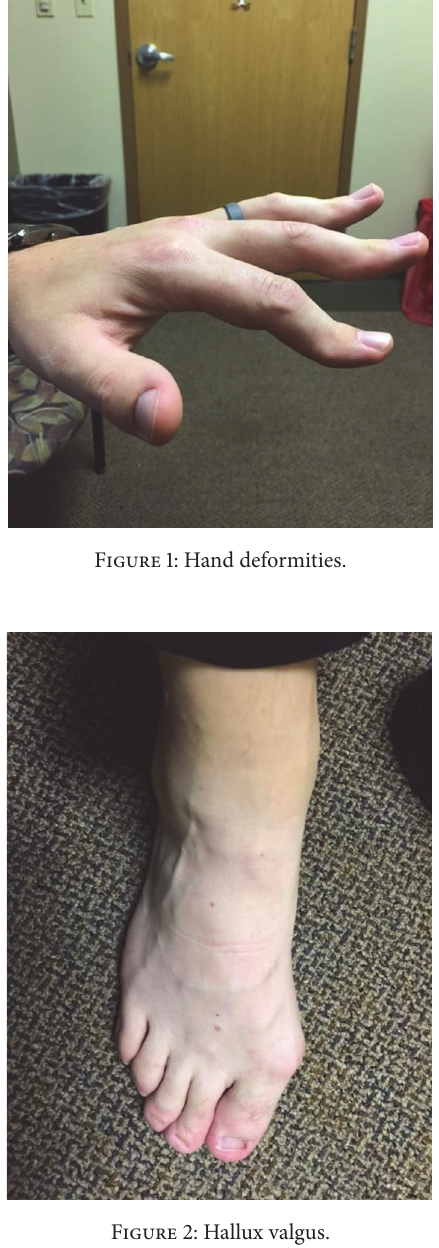
Figure 4: Aortic stenosis with calcified